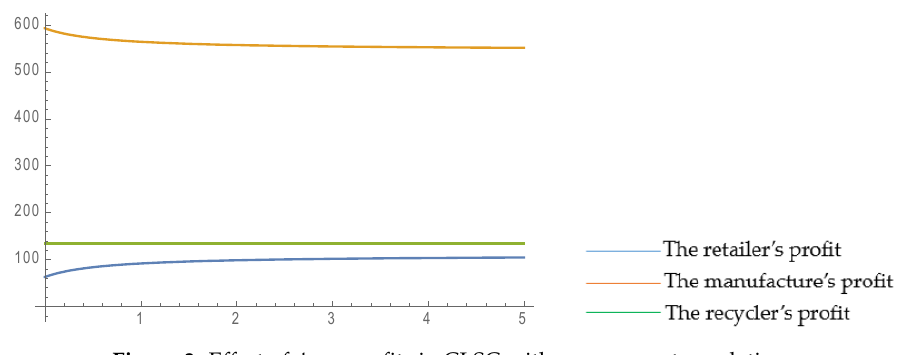
Figure 3. E ff ect of ψ on profits in CLSC with government Figure 3. Effect of  on profits in CLSC with government regulation.